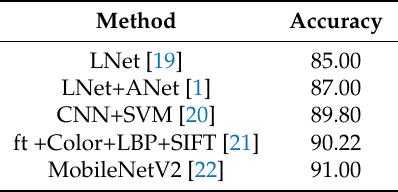
Table 2. The accuracy (expressed in percentage) of various state-of-the-art methods in the task of image annotation on the CelebA data